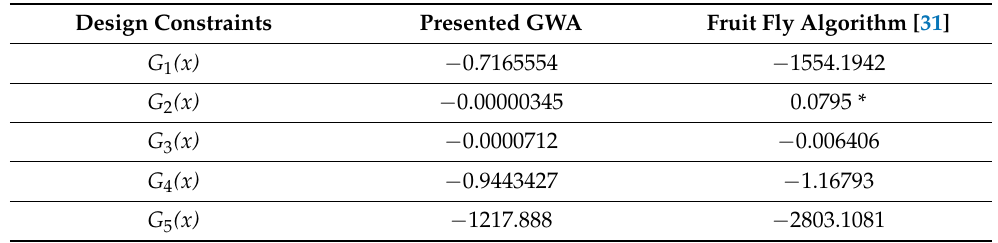
Table 6. Constraints justification based on GWA versus Fruit Fly Algorithm [31] for TLSM design under second case. Design